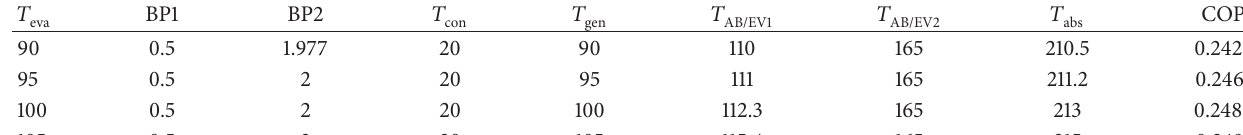
Table 3: The results of optimization for maximum value of the COP.